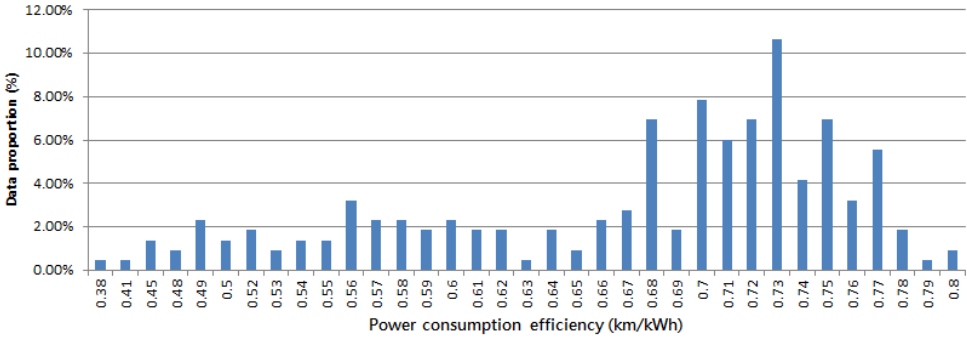
Figure 4. Distribution of the power consumption efficiency in analytical data.